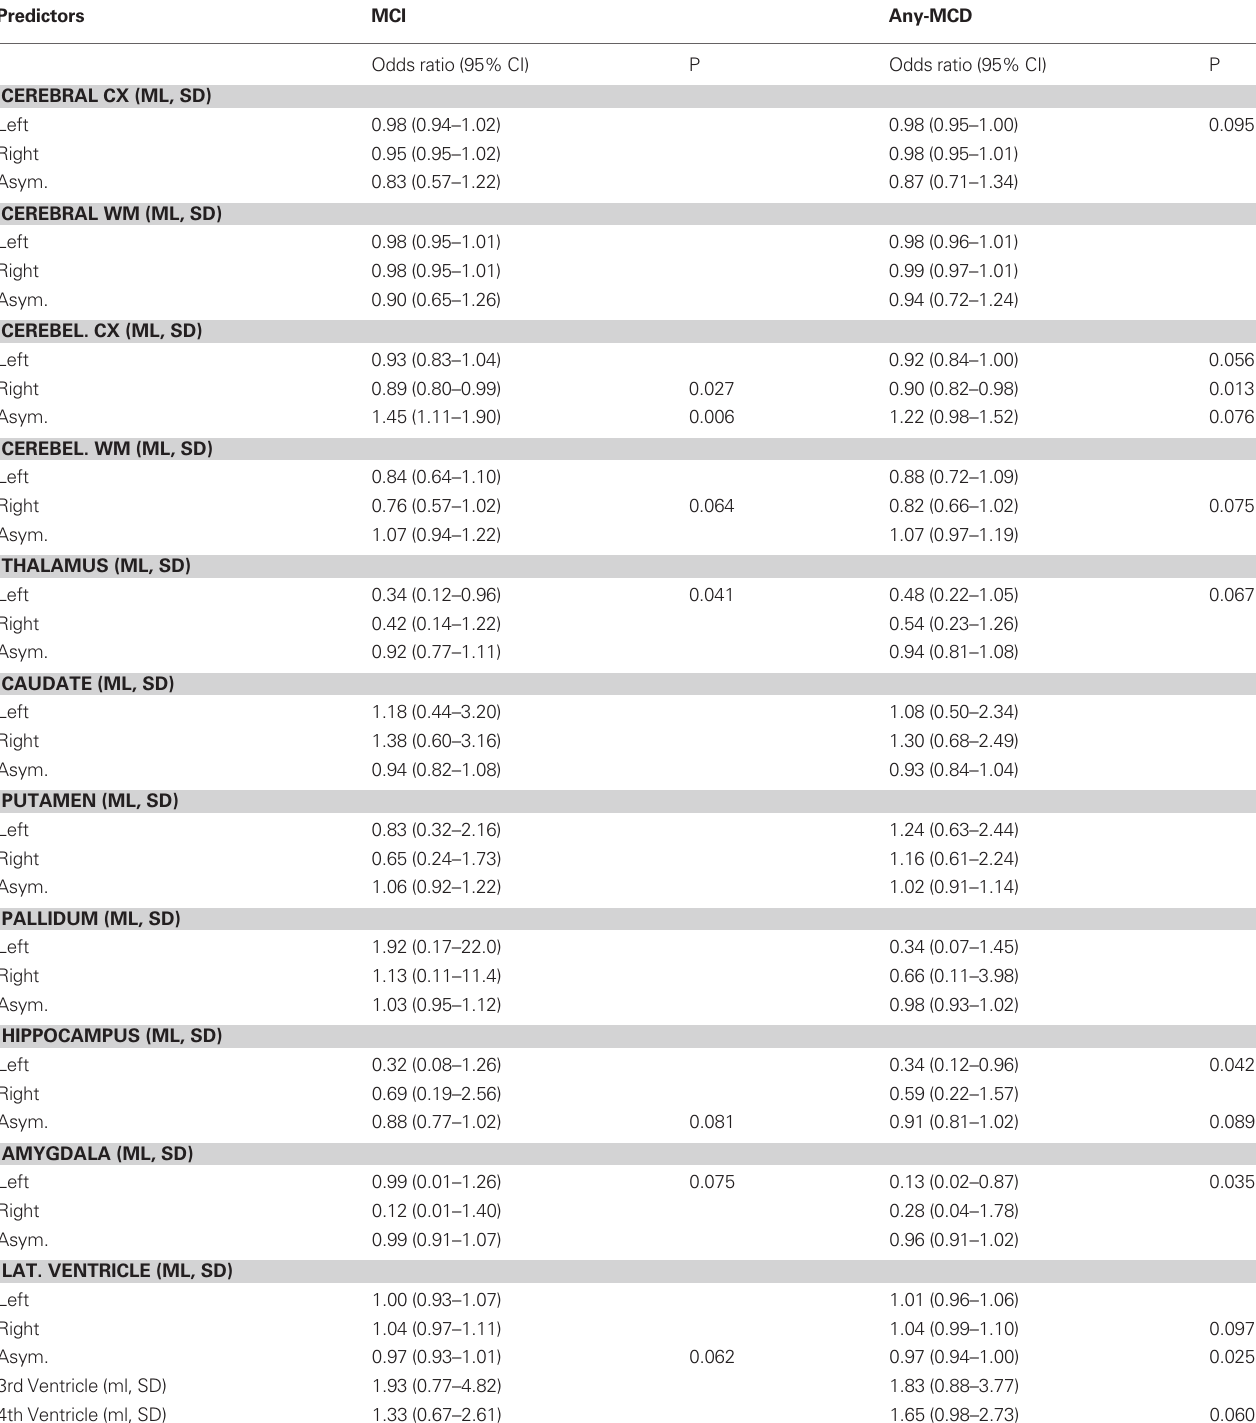
Table 3 | univariate correlates of MCI and any-MCD after controlling for sex, age, and intra-cranial volume.